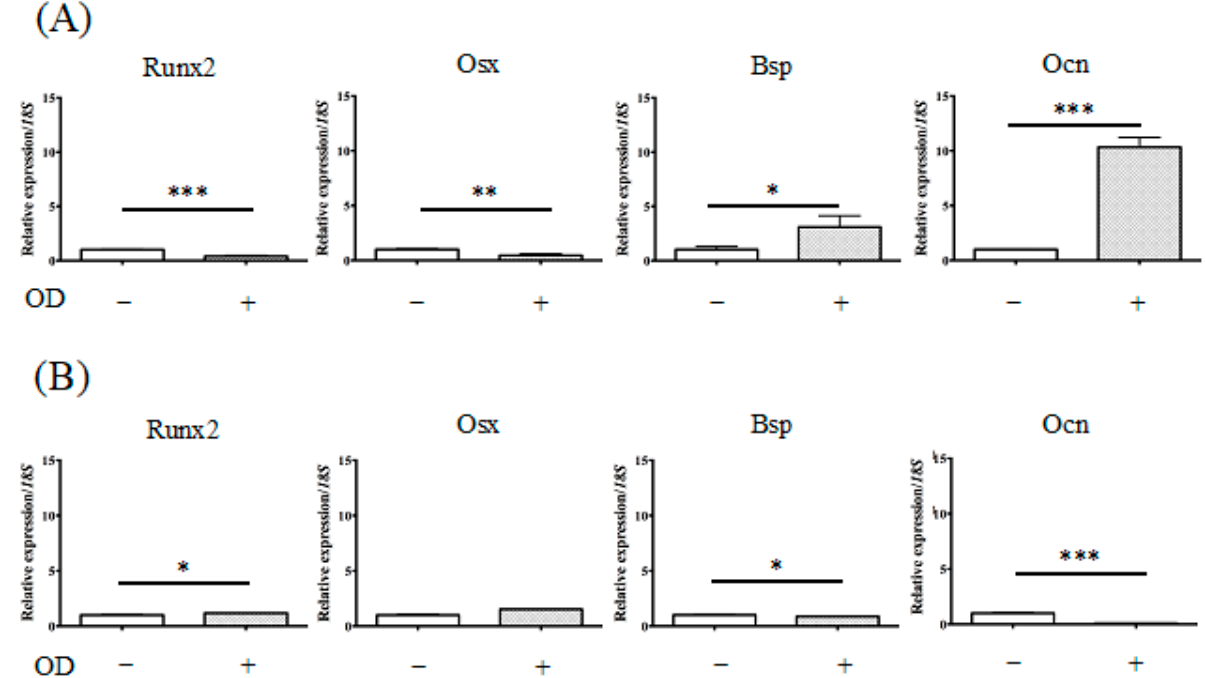
Figure 6. mRNA expression of osteogenesis-related genes in KUSA-A1 cells encapsulated in GelMA–RF hydrogel or GelMAIR hydrogel. ( A ) After 7 days of culture in a 3DRF+ environment, the mRNA expression of Ocn was markedly increased compared with that in the 3DRF environment. ( B ) Runx2 mRNA was significantly increased in 3DIR+ compared with that in the 3DIR environment. These data represent the mean ± SD of four independent experiments. Each experiment was performed in triplicate; * p < 0.05, ** p < 0.01, and *** p < 0.001. 3DRF: KUSA-A1 cells were encapsulated in GelMA-RF hydrogel without osteogenic differentiation medium.